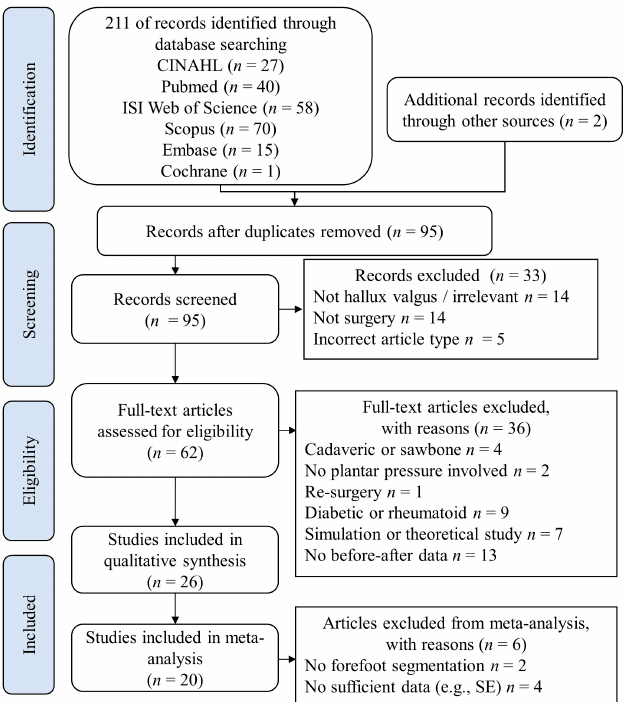
Figure 2. Preferred Reported Items for Systematic Reviews and Meta-Analyses (PRISMA) flowchart for systematic review. CINAHL: Cumulated Index to Nursing and Allied Health Literature; SE: Standard Error.